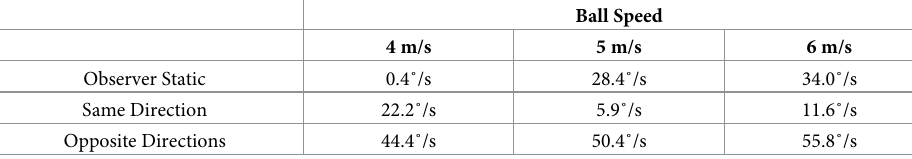
Table 1. Mean absolute retinal speeds across the visible part of the trajectory for each combination of ball speed and observer motion profile. The script in which we derive these values can be found on GitHub (https://github.